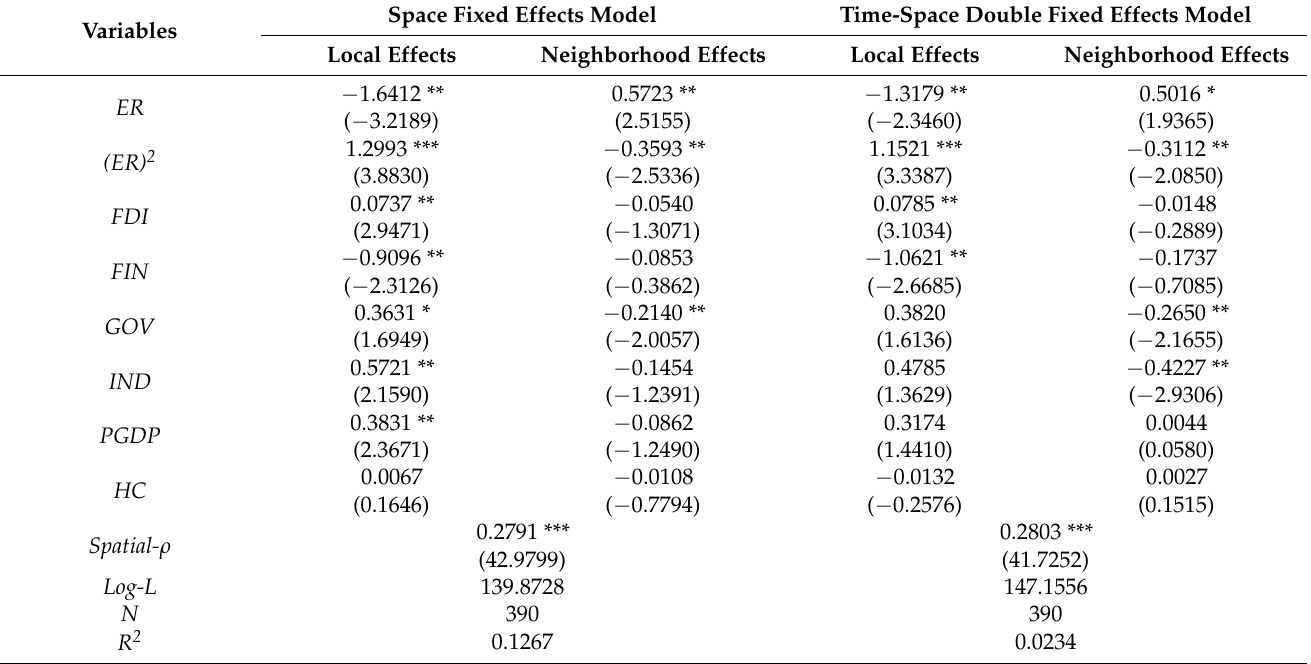
Table 6. The “local neighborhood” effect